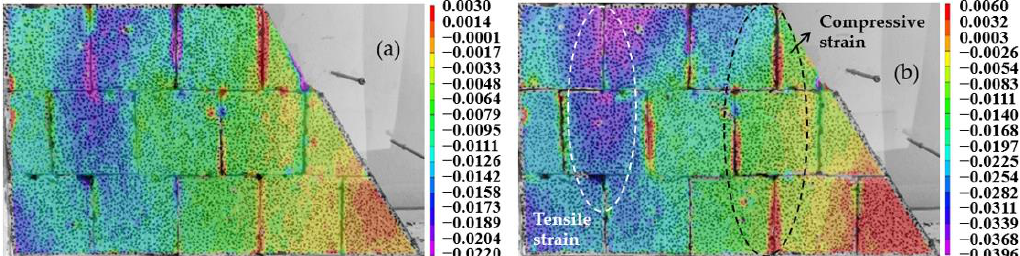
Figure 11. Strain contours of the slope model with horizontal crack networks under different loadings. ( a ) Under 1.6 MPa; ( b ) under 16 MPa.